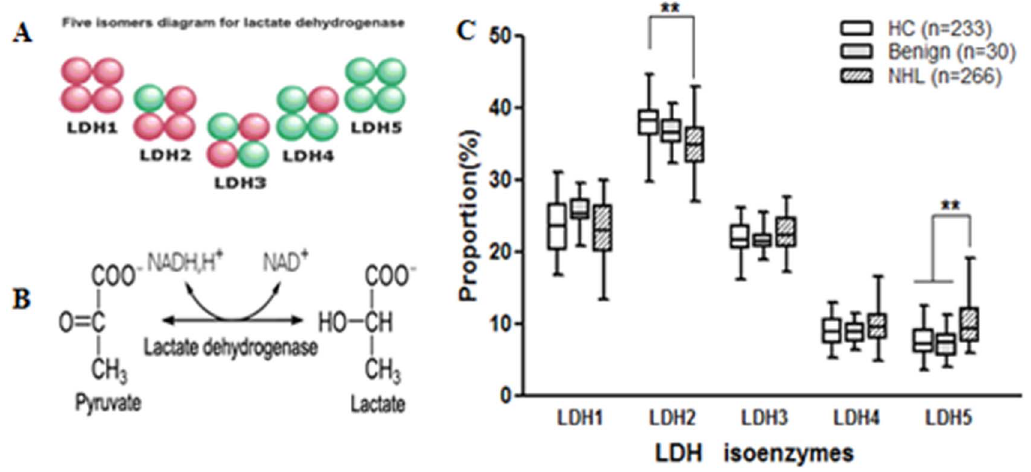
Figure 1. Comparison of expression levels of the five LDH isoenzymes. (A) Schematic depicting the five isomers of LDH, indicating subunit composition. (B) LDH enzymes catalyze the metabolism of pyruvate to lactate to acquire the energy in the glycolytic pathway. (C) Expression levels of the five LDH isoenzymes in the serum of patients with NHL (NHL) and benign (Benign) or healthy controls (HC). **, P , 0.01.